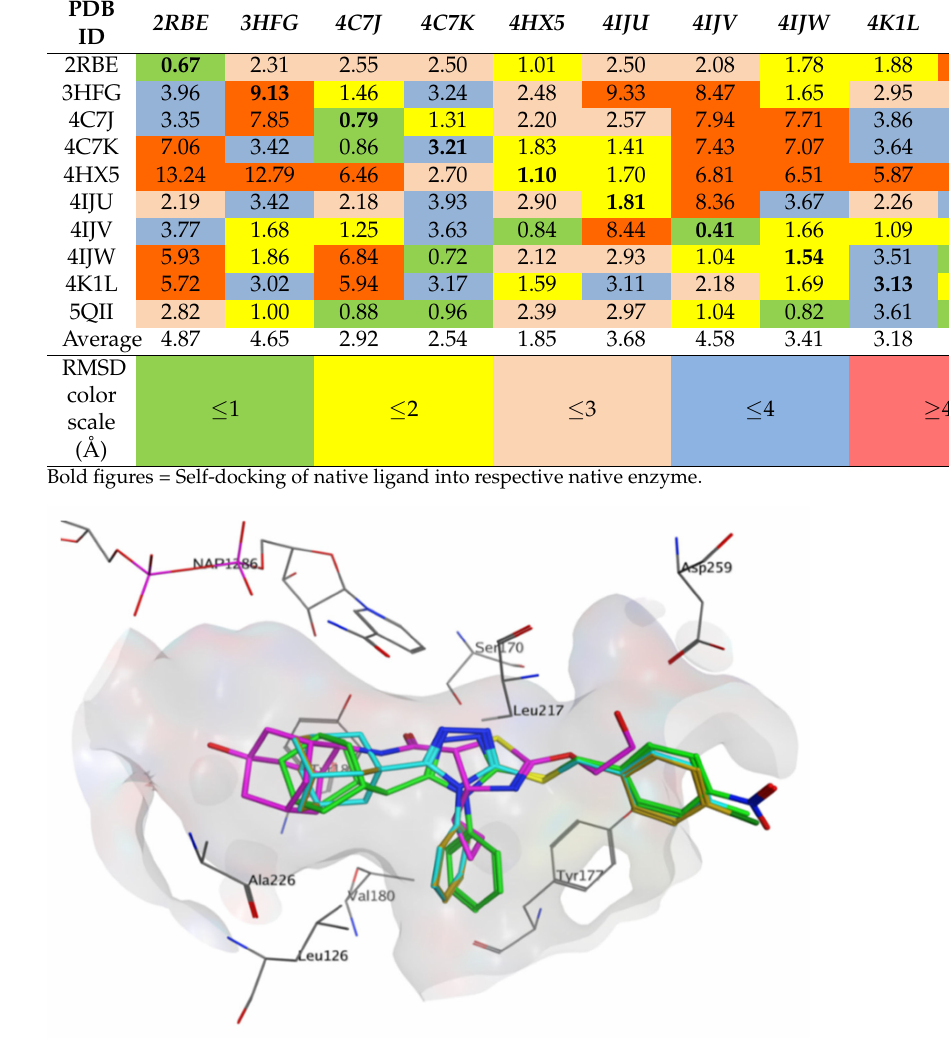
Figure 10. The binding orientations of 4YQ (magenta) and compounds 1 (green), 2 (blue), 3 (green) within the 11 β -HSD1 active site using MOE 2020 software suite [53]. The shift of compounds 1 – 3 towards the entrance of the active site, the exposure of the substituents of the benzylsulfanyl moiety to the external environment as well as the rotation of the triazole moiety towards the NAP co-factor and it’s out of plane nature in reference to Ser 170 and Tyr 183 was observed. Hydrogens were removed for illustration